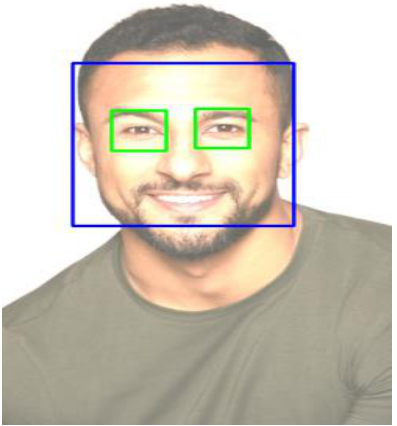
Figure 15. After increasing the brightness of Figure 13.